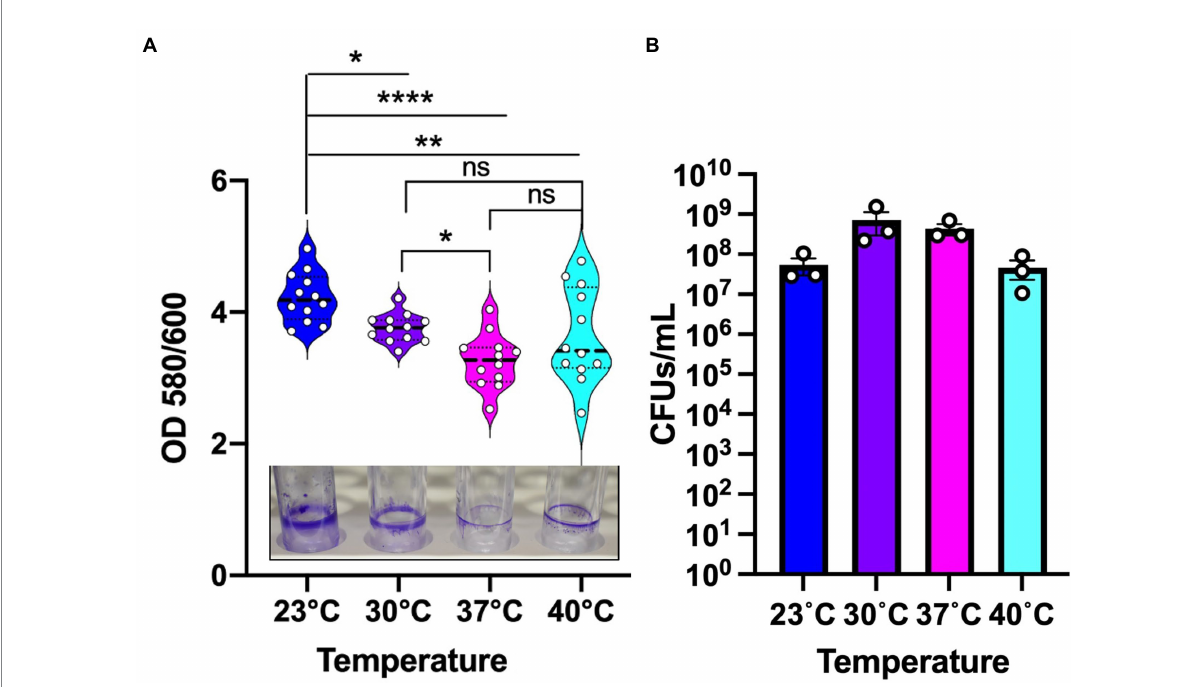
FIGURE 1 Environmental temperature biofilm is associated with higher biomass on polystyrene surfaces. (A) The biomass of the biofilm formed at the four temperatures. Violin plots represent means of three experiments with four replicates per sample. Crystal violet staining revealed subtle temperature-dependent architectural differences at the four temperatures. The center black line represents the interquartile range. Unpaired t-test (two-tailed) was used to measure statistical significance. ns: not significant, * p ≤ 0.05, ** p ≤ 0.01, and **** p ≤ 0.0001. (B) CFU count of PA14 WT planktonic cells at environment versus host temperature. After 48 h of growth, the cultures were serially diluted in sterile 1X PBS and plated on LA plates. Plates were grown overnight at 37 ° C for sufficient colony formation. Error bars represent the standard error of mean of three biological replicates. The mean of each biological replicate was based on eight technical replicates after outlier